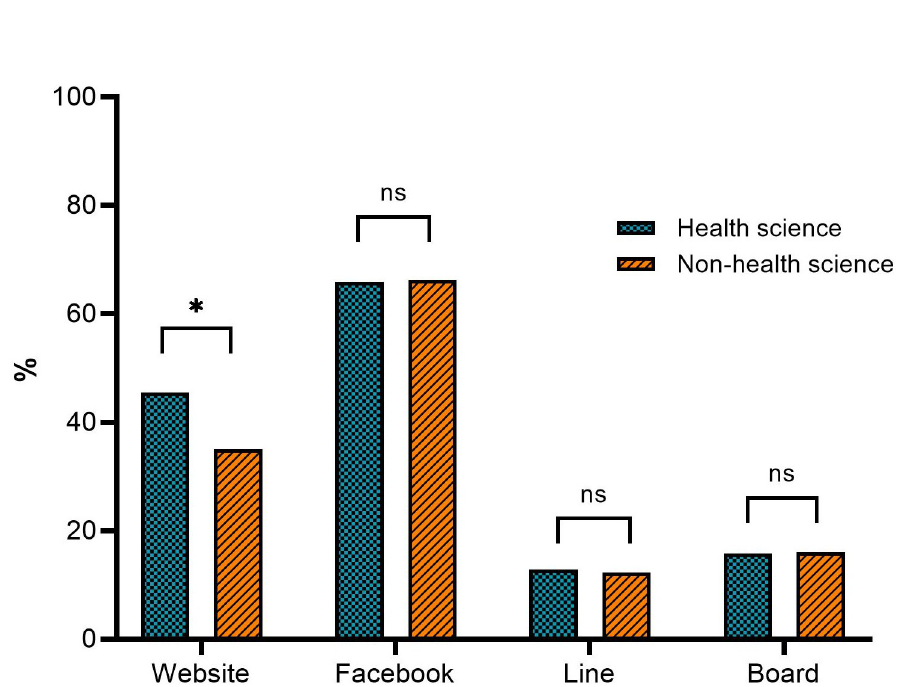
Fig 2. The information sources of facemask disposal among HS (N = 196) and NHS students (N = 237). * indicates a significant different between HS and NHS students at p < 0.05, while ns indicates no significant.